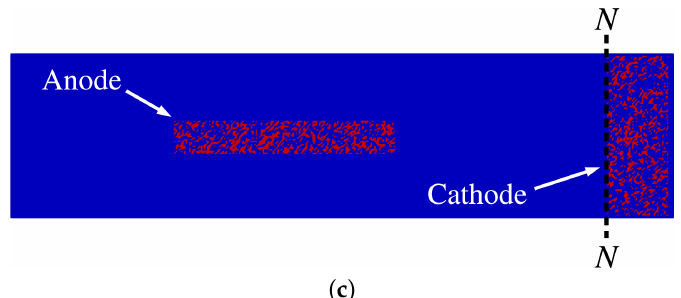
Figure 8. Experimental MFC reactor components and reconstructed computational domain; ( a ) carbon-fiber anode brush; ( b ) ceramic porous cathode; ( c ) domain configuration for the LBM simulations.